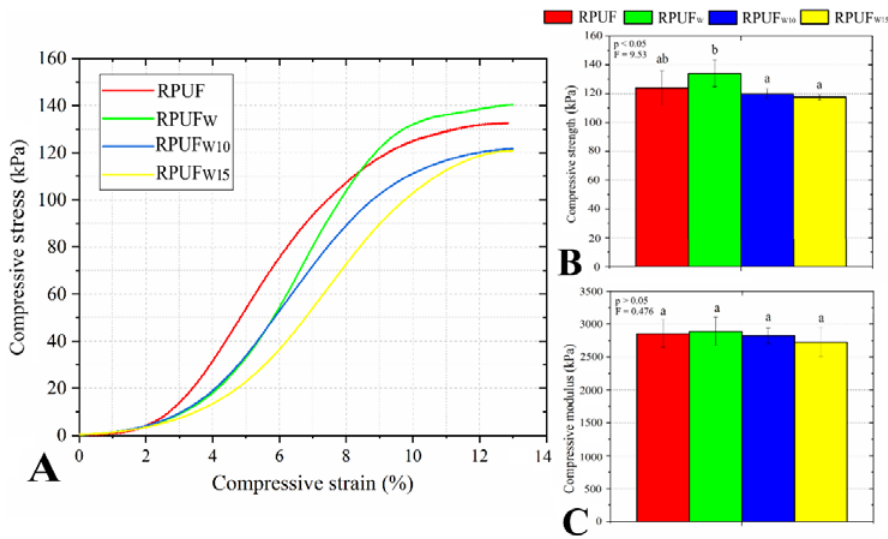
Figure 6. Representative stress vs. strain curves ( A ) and compressive properties ( B , C ) of the studied RPUFs. Different letters represent statistically different means.